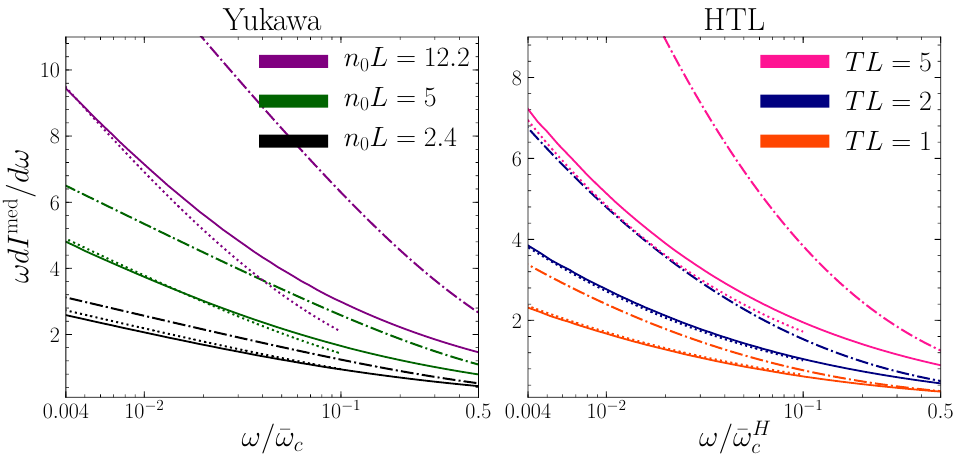
Figure 1 . Left panel: fully resummed medium-induced gluon energy distribution for the Yukawa collision rate (solid lines), its low energy limit given by eq. (4.6) (dotted), and the GLV N = 1 result (dash-dotted) as a function of x = ω/ ¯ ω c = 2 ω/ ( µ 2 L ) for different values of n 0 L . Right panel: fully resummed medium-induced gluon energy distribution for the HTL collision rate (solid lines), its low energy limit given by eq. (4.6) (dotted), and the GLV N = 1 result (dash-dotted) as a function of x = ω/ ¯ ω c = 2 ω/ ( m 2 L ) for different values of TL D